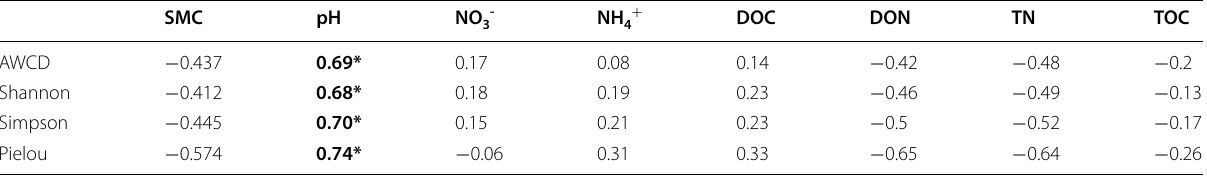
Table 4 Correlation between soil environmental factors and soil microbial functional diversity under different nitrogen addition